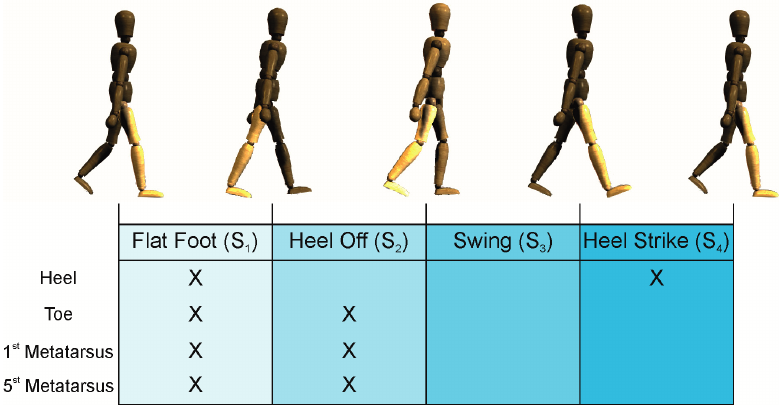
: Flat Foot, S : Heel 1 2